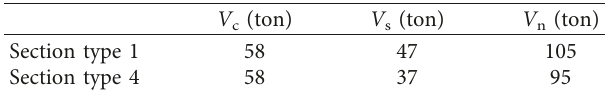
Figure 18: Collapse process of regular, semiregular, and irregular bridges (b2222222, b213, and b2331312, respectively) under (a) Chi-Chi earthquake, (b) Northridge earthquake, and (c) Kobe earthquake. Table 5: Shear strength of the bridge section type of